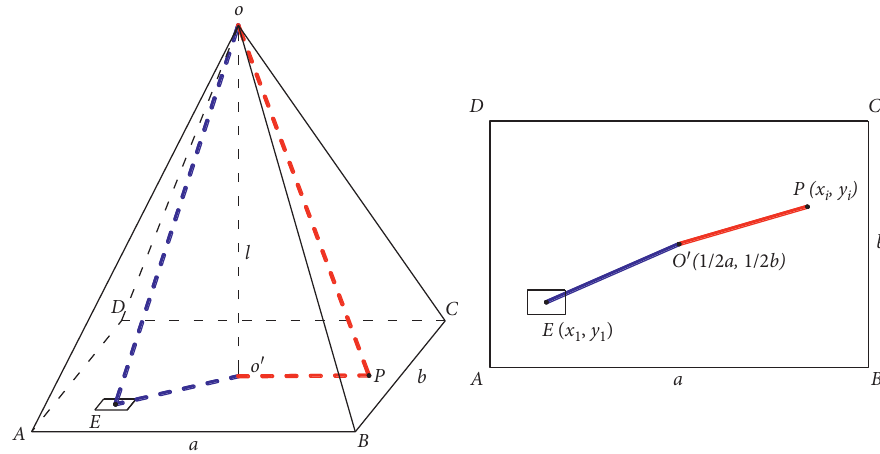
Figure 5: Schematic diagram of scale deviation